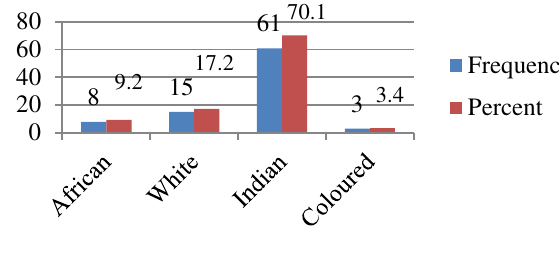
Fig. 3. Race group of participants